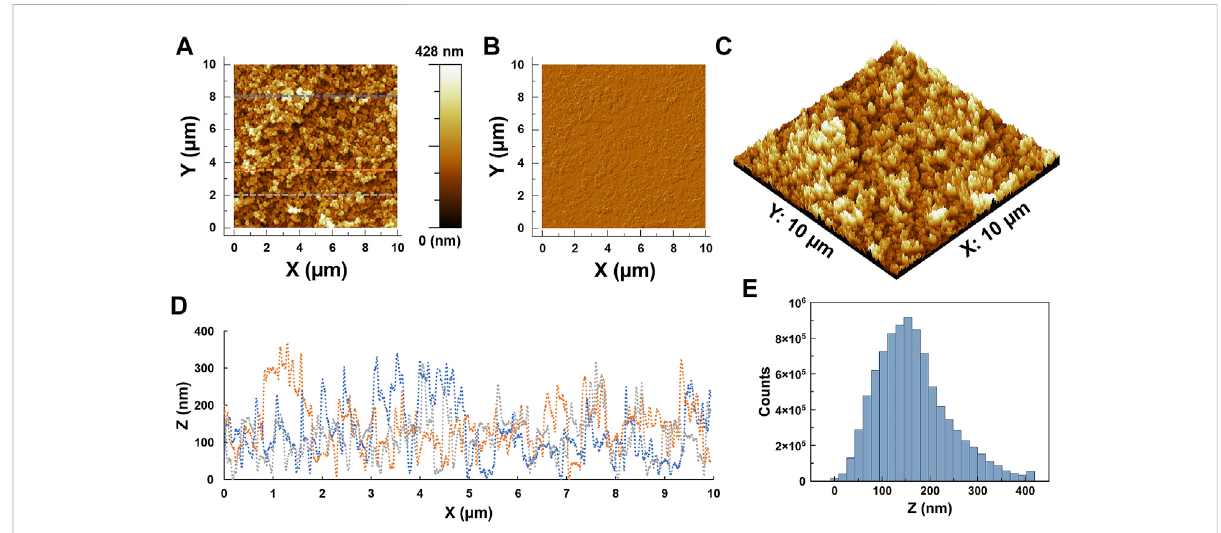
FIGURE 3 Atomic force microscopy of ZnO/Zn(OH) 2 coatings fabricated on glass slides: (A) A topography image, and corresponding (B) phase image, (C) 3-dimensional topography map, (D) surface pro fi les, and (E) surface roughness analysis histogram.